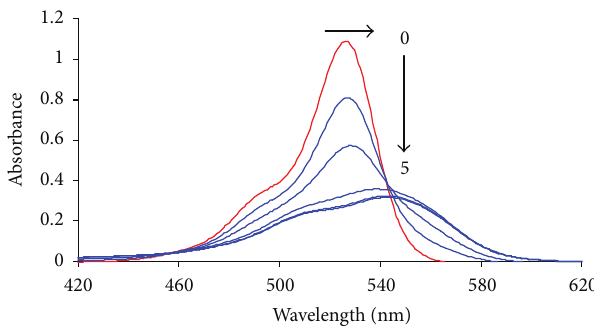
Figure 2: Absorption spectrum of FN ( 1 × 10 −5 M; red color) in the presence of colloidal SnO 2 ( 0 – 5 × 10 −4 M; blue color) in water. The arrow indicates the absorbance decreases on increasing concentra- tion of colloidal SnO 2 .